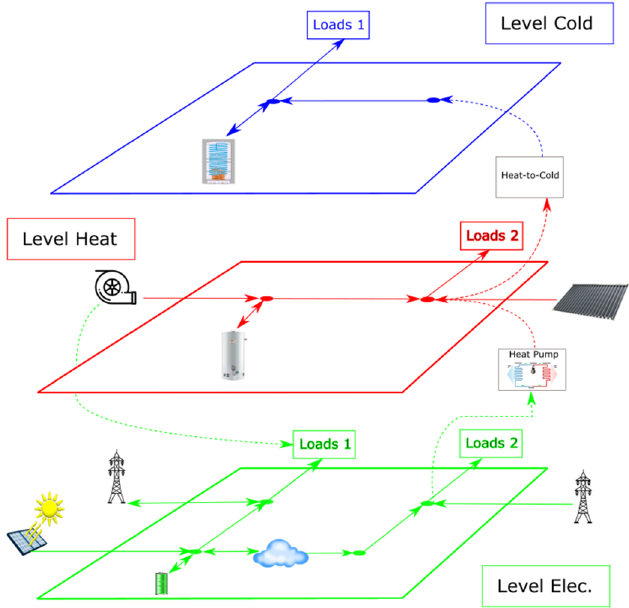
Fig. 1. Scheme of a two-participants